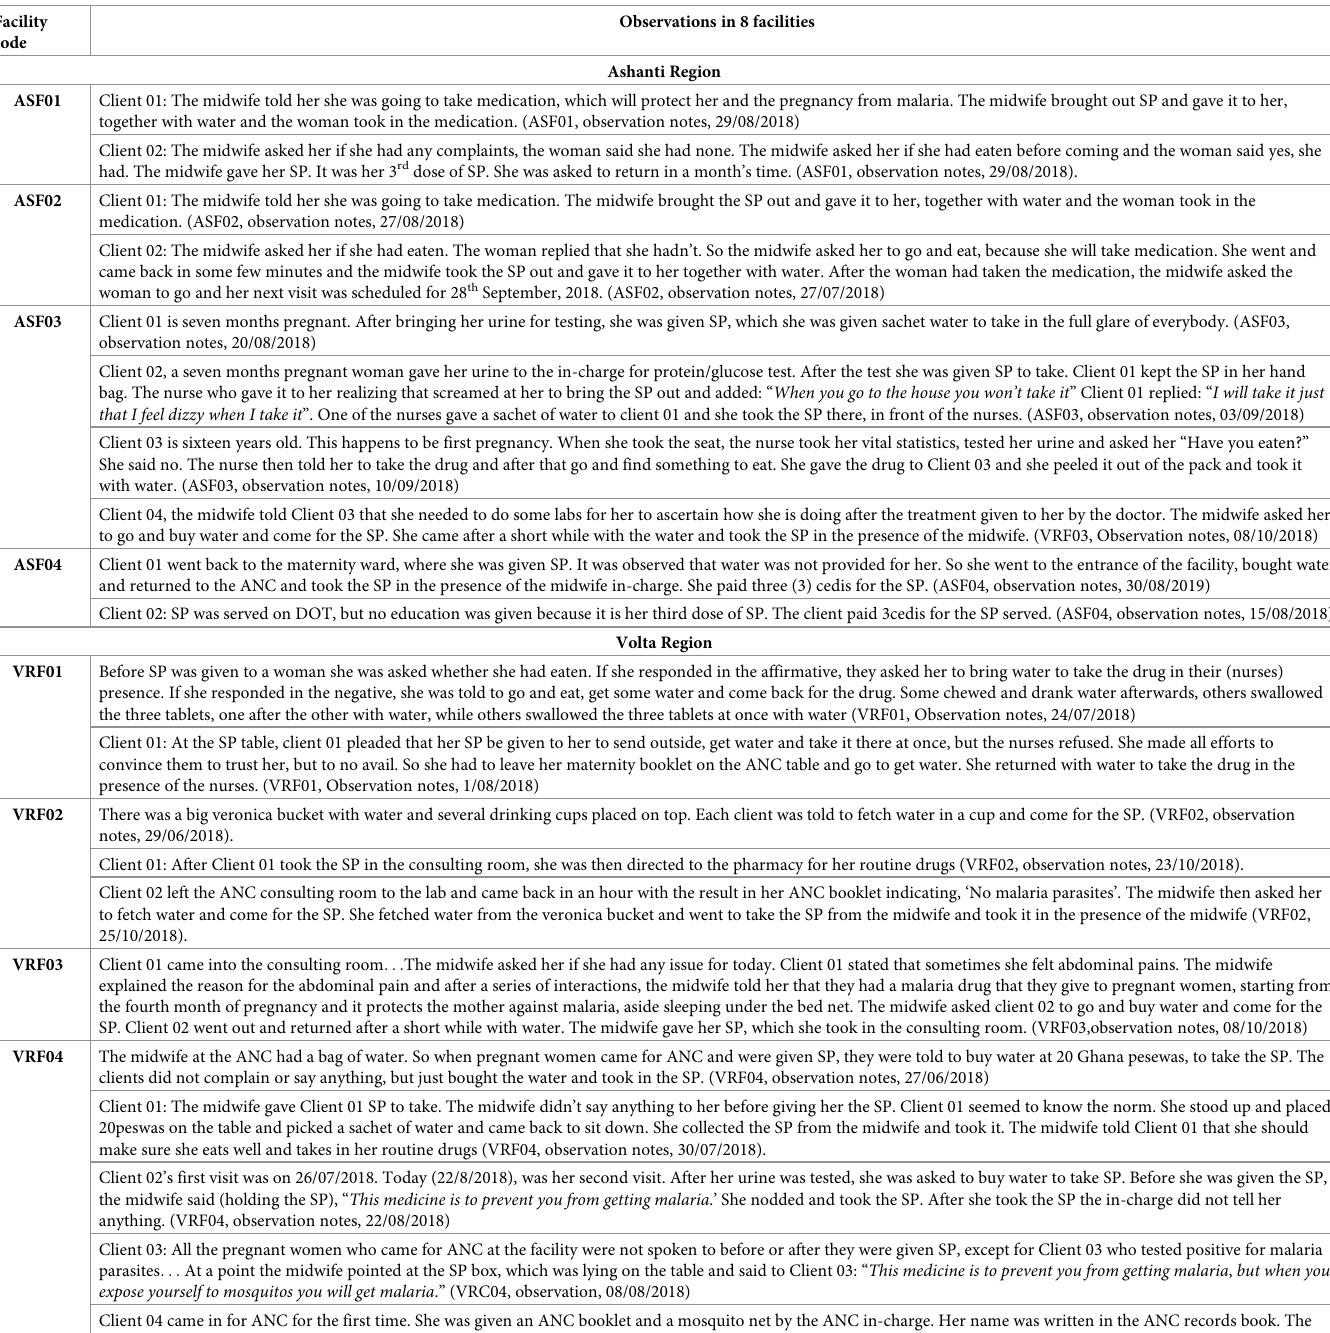
Table 4. Observations in 8 ANC clinics on SP intake under